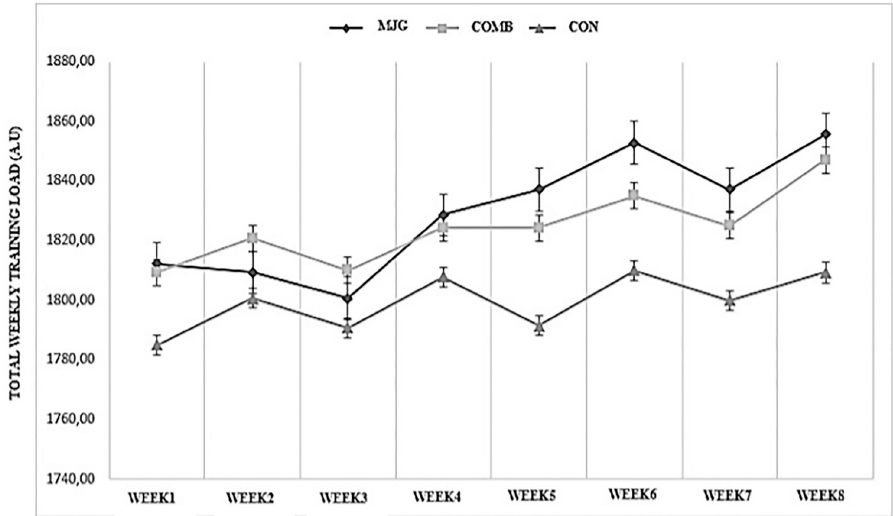
Fig 3. Total weekly training load for the MJG, COMB and